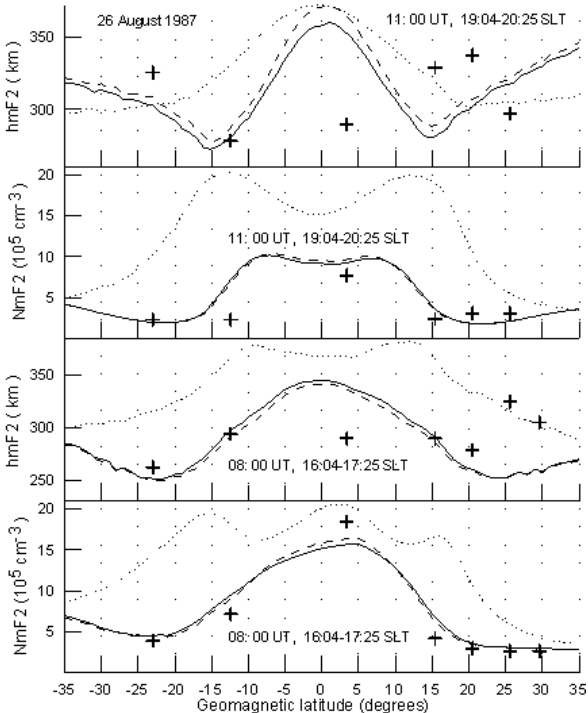
Fig. 16. Observed (crosses) and calculated (lines) hmF 2 and NmF 2 at 02:00 UT (two lower panels) and 05:00 UT (two upper panels) on 27 August 1987. The measured hmF 2 and NmF 2 are taken from the ionospheric sounder station listed in Table 1. The curves are the same as in Fig.